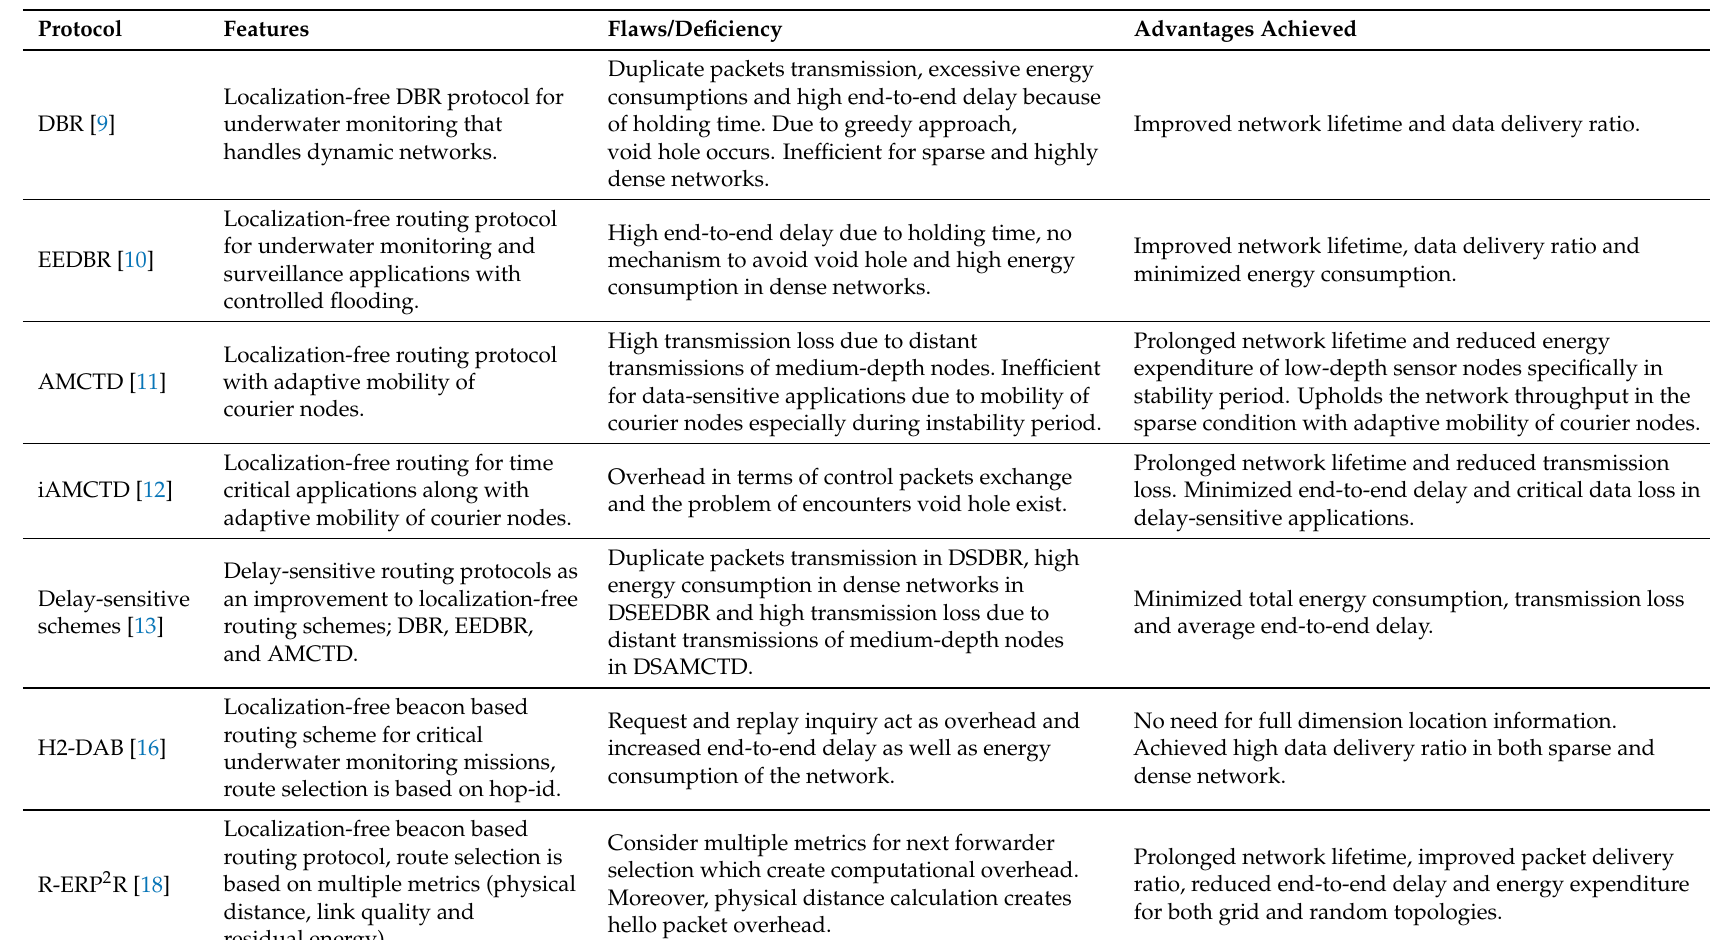
Table 1. Comparison of different existing